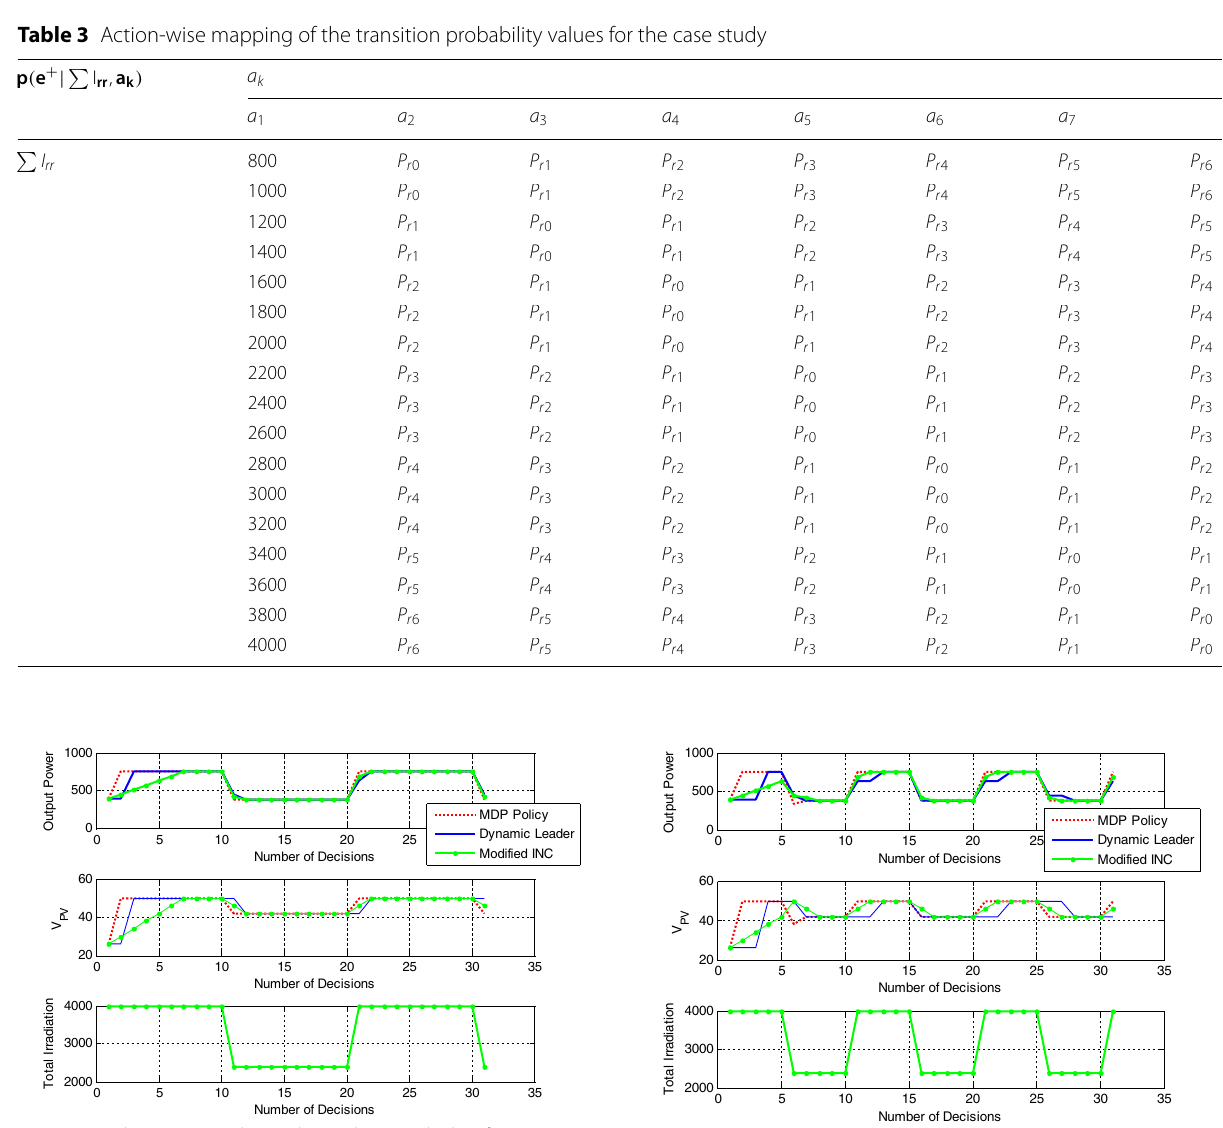
Fig. 7 Irradiance versus photovoltaic voltage under low frequency variations